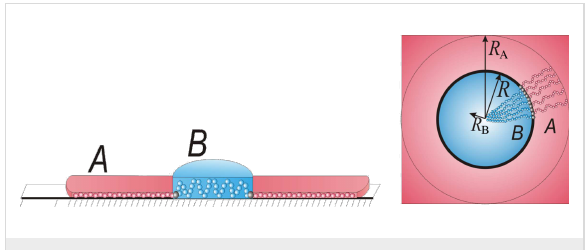
Figure 5: Schematic representation of the disc-shaped